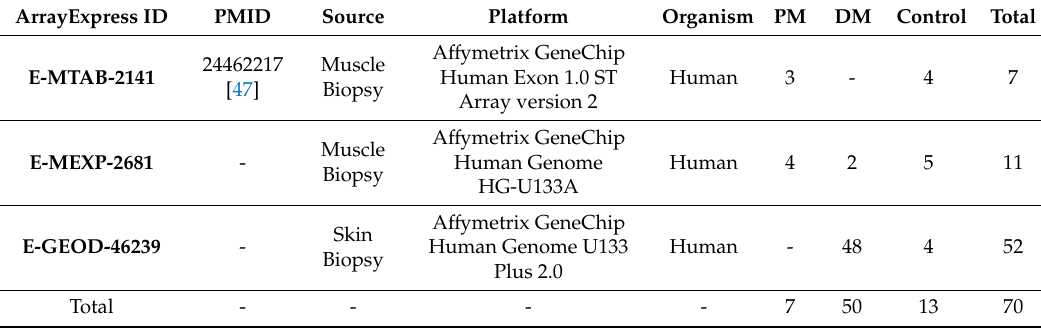
Table 1. Information on the datasets included in this